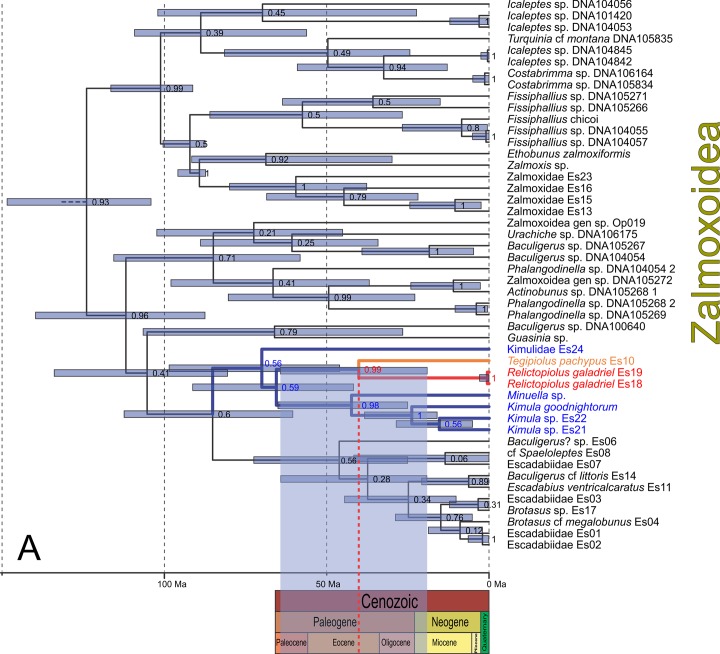
Chronogram (partim, Zalmoxoidea) obtained by Bayesian inference analysis, conducted in BEAST, using the complete concatenated dataset.(A) Chronogram with support values at nodes represent posterior probabilities and blue bars represent the 95% Highest Posterior Densities (HPD) around the estimated age of the most recent common ancestor. Colored branches and names of taxa represent the family Kimulidae. Below the chronogram, a geologic time scale of the Cenozoic Era (present-65 Ma) is shown. The vertical red-dotted line indicates the divergence time (40.1 Ma) between Relictopiolus galadriel
gen. nov., sp. nov. and Tegipiolus pachypus Roewer, 1949, projected over the geologic time scale with a blue shaded box that indicates the 95% HPD.